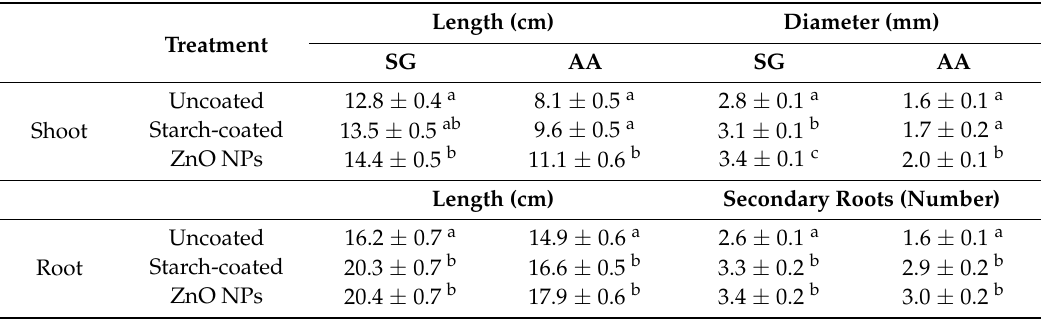
Table 2. Effect of ZnO NPs on maize seedling vigor during standard germination and accelerated aging